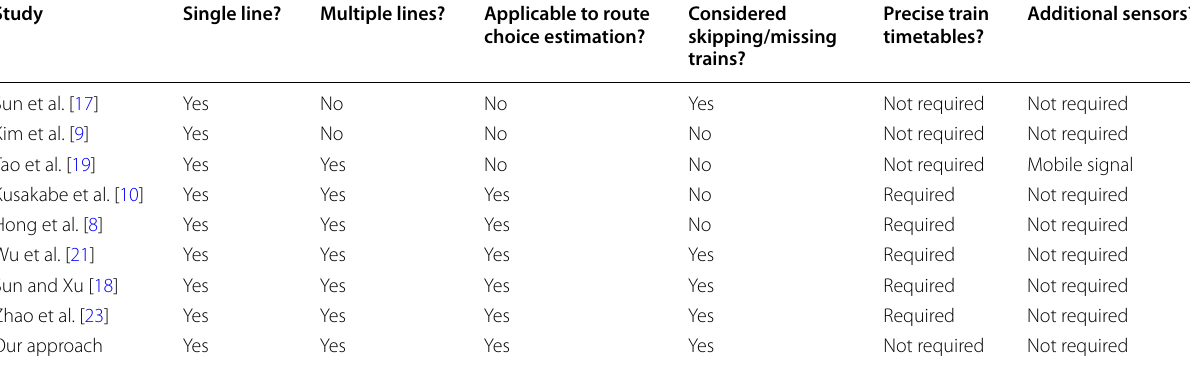
Table 1 Studies on inferring passenger route choice behavior in urban rail systems